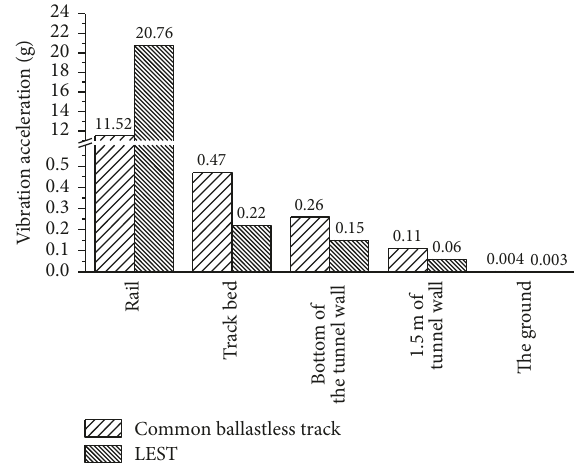
Figure 12: Average vibration accelerations at different measuring points in straight